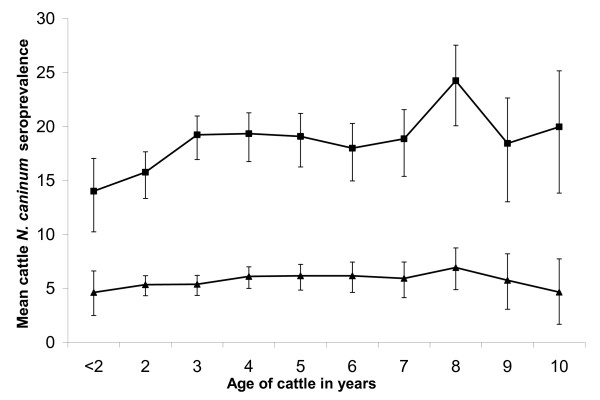
Age-specific N. caninum antibody seroprevalence for cattle ≥ 2 years of age sampled at the three routine herd visits (Dataset B – 26,437 samples, 13,942 cattle, 114 herds, only cattle ≥ 2 years old for regular visits in the 4-year study period) by herd seroprevalence to N. caninum < 10% and ≥ 10%. Squares represent cattle from herds with a mean seroprevalence < 10% and triangles represent cattle from herds with a mean seroprevalence ≥ 10%.